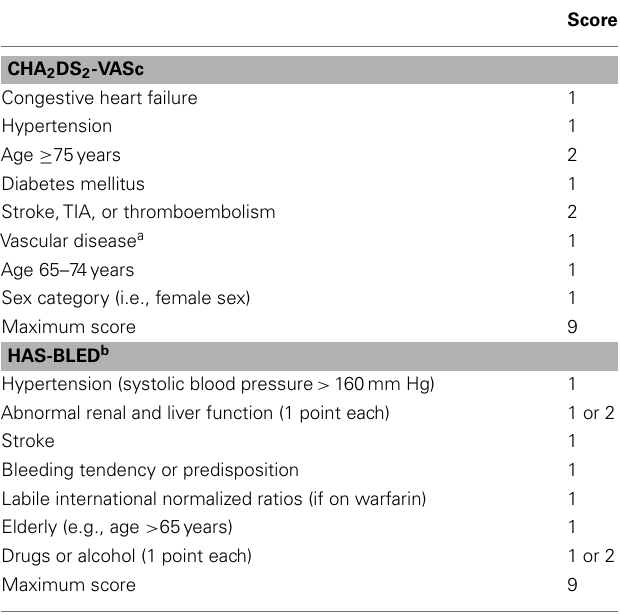
Table 2 | Current risk stratification schemes advocated in the new European guidelines for the management of atrial fibrillation